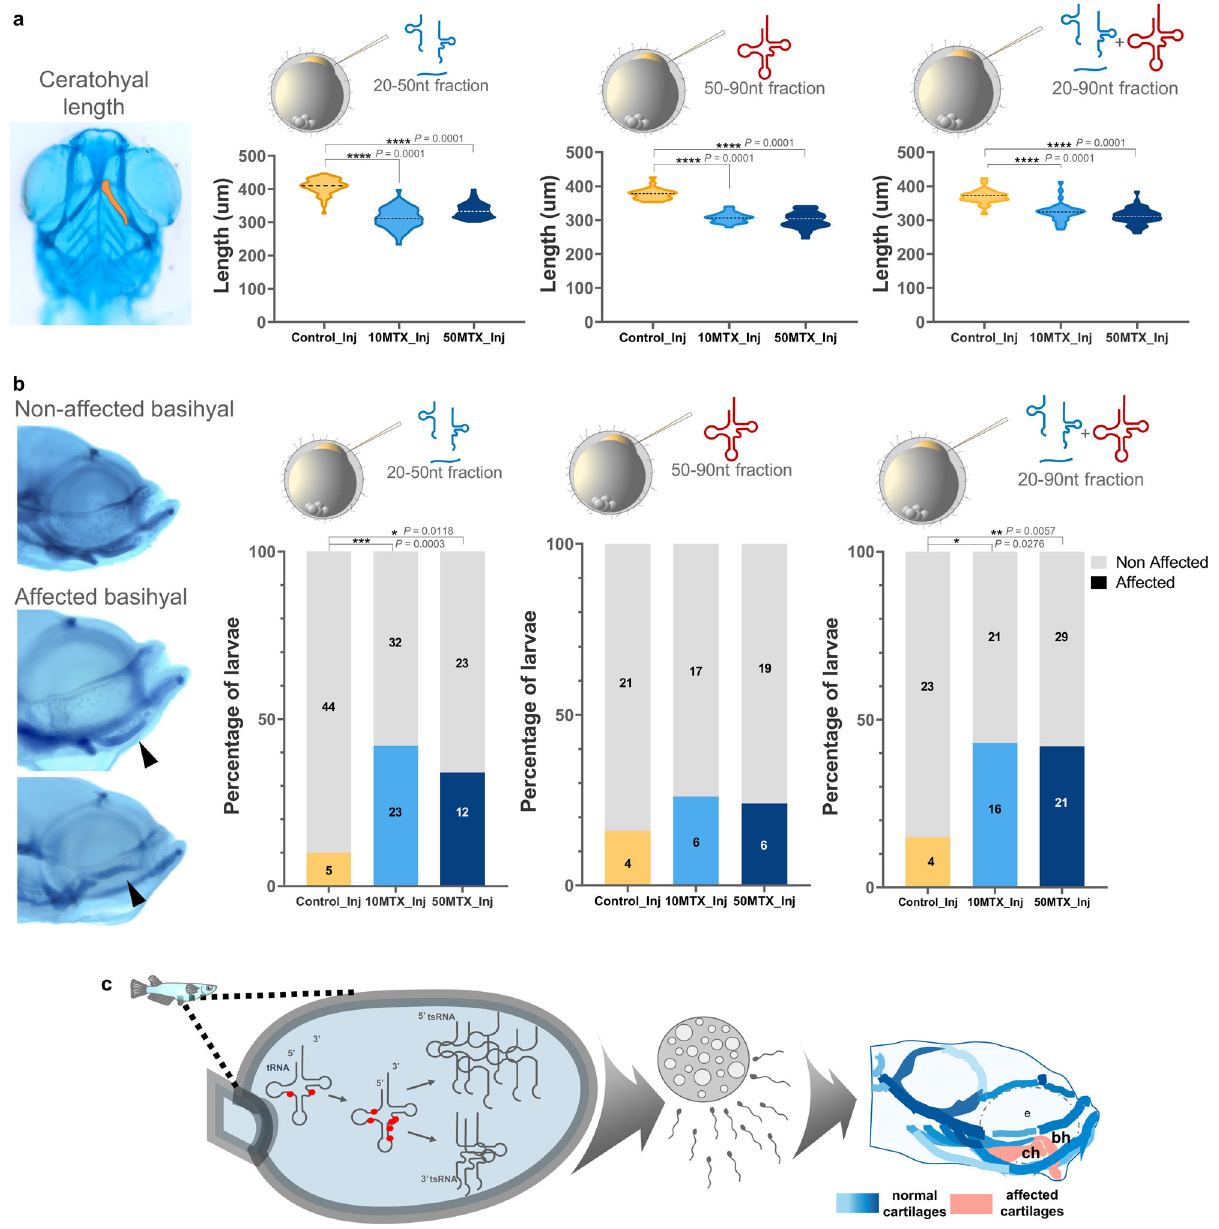
Fig. 6 | Zygotic RNA injection derived from MTX-treated sperm partially reca- pitulates the craniofacial phenotype. a Violin plots represent the measurement of ceratohyal lengths on wild-type fertilized eggs injected with sperm-RNA frac- tions (20 – 50nt, 50 – 90nt, or both together) obtained from control, 10MTX and 50MTX treated males. Statistical analyses were performed using ANOVA one-way followed by multiple comparison Tukey ’ s test. b Lateral view of larvae presenting non-affected (trowel shape) or affected (bended upward or downward) basihyal